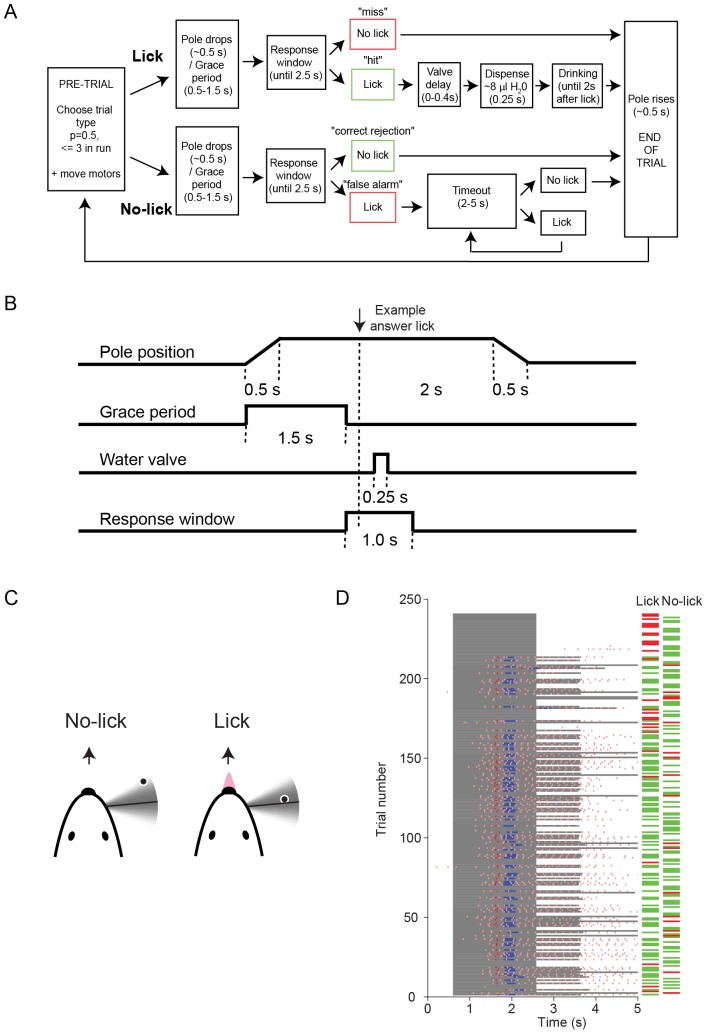
A lick/no-lick object location discrimination task for head-fixed mice [23].A. Block-diagram of the possible events in a single trial. B. Schematic representation of event timing during a single lick trial. C. Schematic representation of the behavioral contingency. Mice had to lick for a water reward when the pole was in a posterior position and hold their tongue when the pole was in an anterior position. In some experiments, the contingency of the pole positions was reversed. D. Behavioral data from one session. The abscissa shows the time from trial start. Lick and no-lick trials are randomly interleaved. The pink ticks indicate licks. The red ticks indicate the first licks after the grace period. The blue bars correspond to the open times of the reward water valve. The horizontal green and red bars indicate whether each trial is correct or incorrect, respectively. The dark gray shading indicates that the pole is fully descended and in reach of the whiskers.